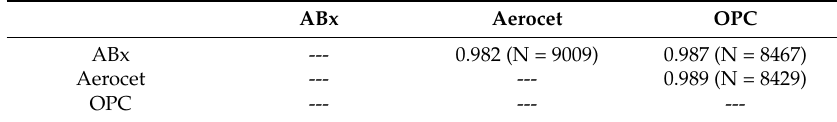
Table 7. Correlations between direct-reading instruments (1-min average). All correlations are significant at 0.001 level. Spearman’s rank order correlation (rho) is reported in the